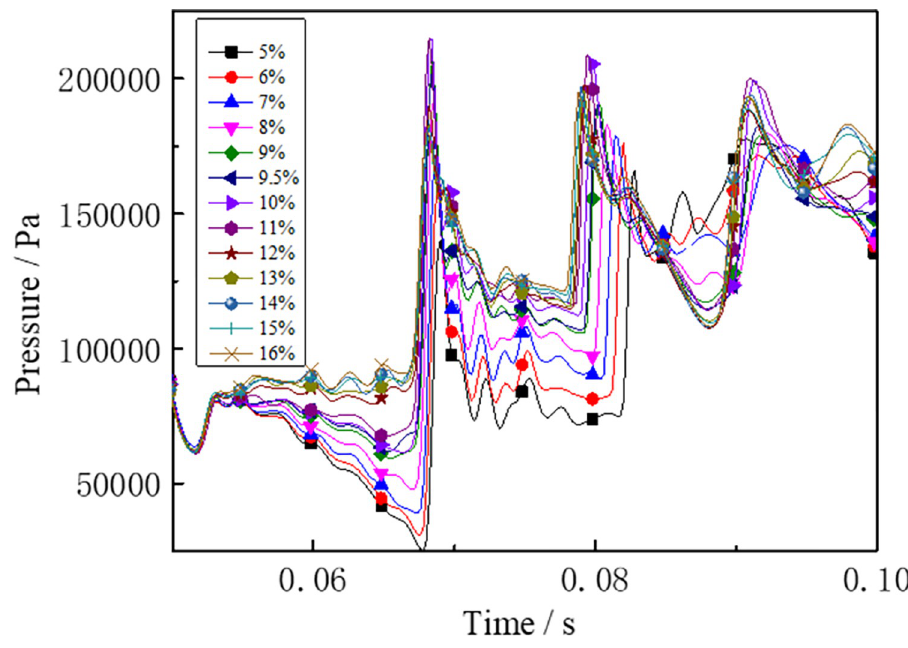
Fig 14. Pressure—Time curves and peak at monitoring point 6 at different gas concentrations (sequence chart).